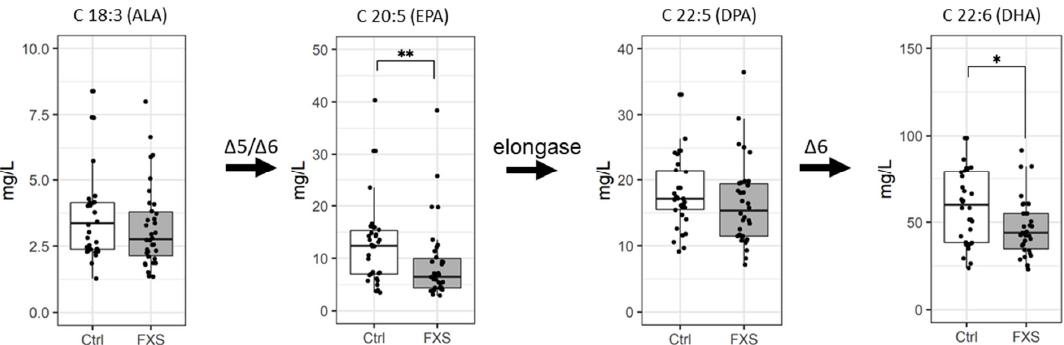
Figure 2. Concentrations of selected ω‐ 3 FAs in plasma. Levels are expressed as mg/L of plasma. * p ≤ 0.05; ** p ≤ 0.01, Δ 6, delta6 ‐ desaturase; Δ 5, delta5 ‐